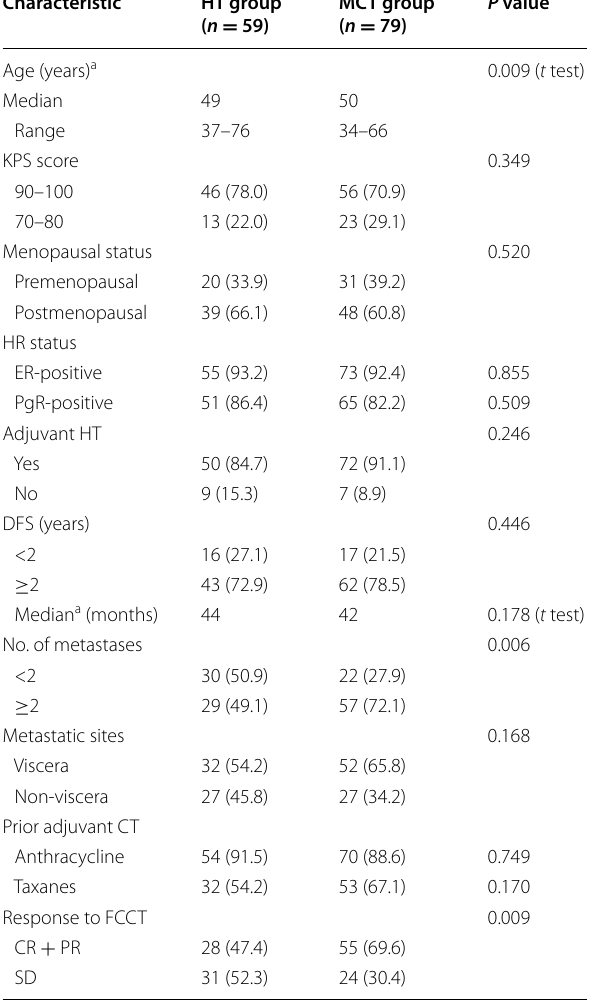
Table 1 Demographic and baseline characteristics of 138 patients with metastatic breast cancer